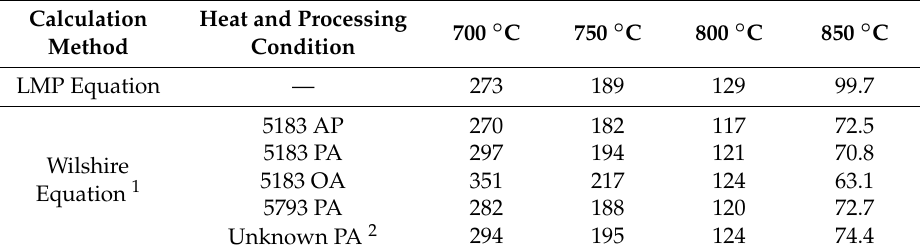
Table 13. Calculated creep strength for rupture at 100,000 h (MPa) of Nimonic